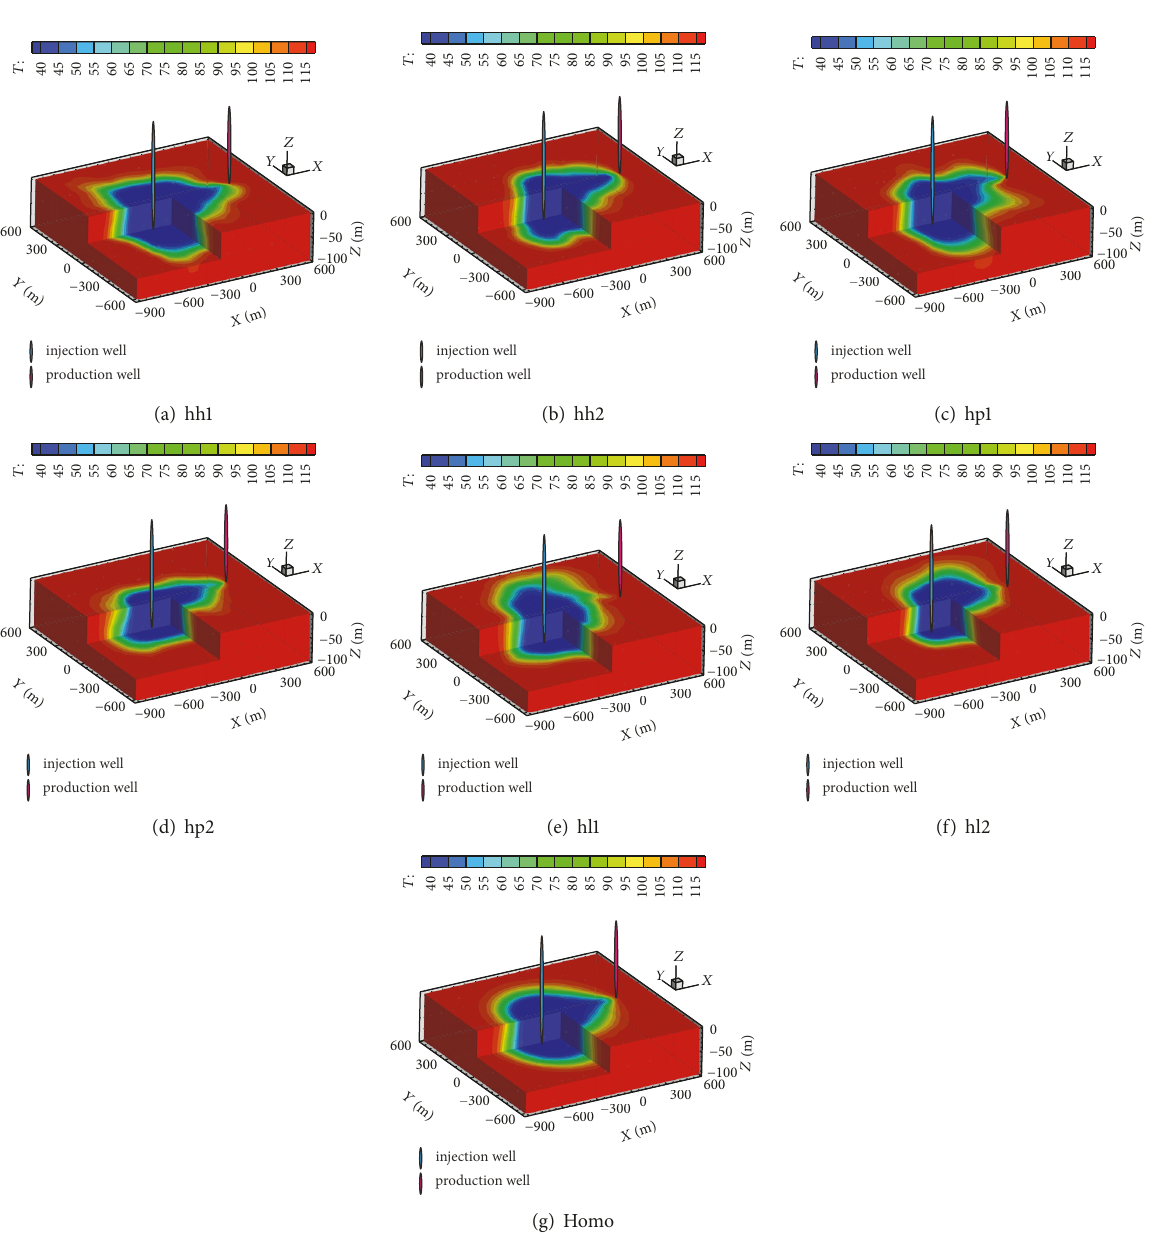
Figure 10: Temperature distribution of reservoir after 20